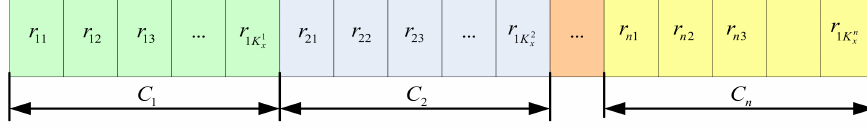
Figure 6. The Structure diagram of chromosome